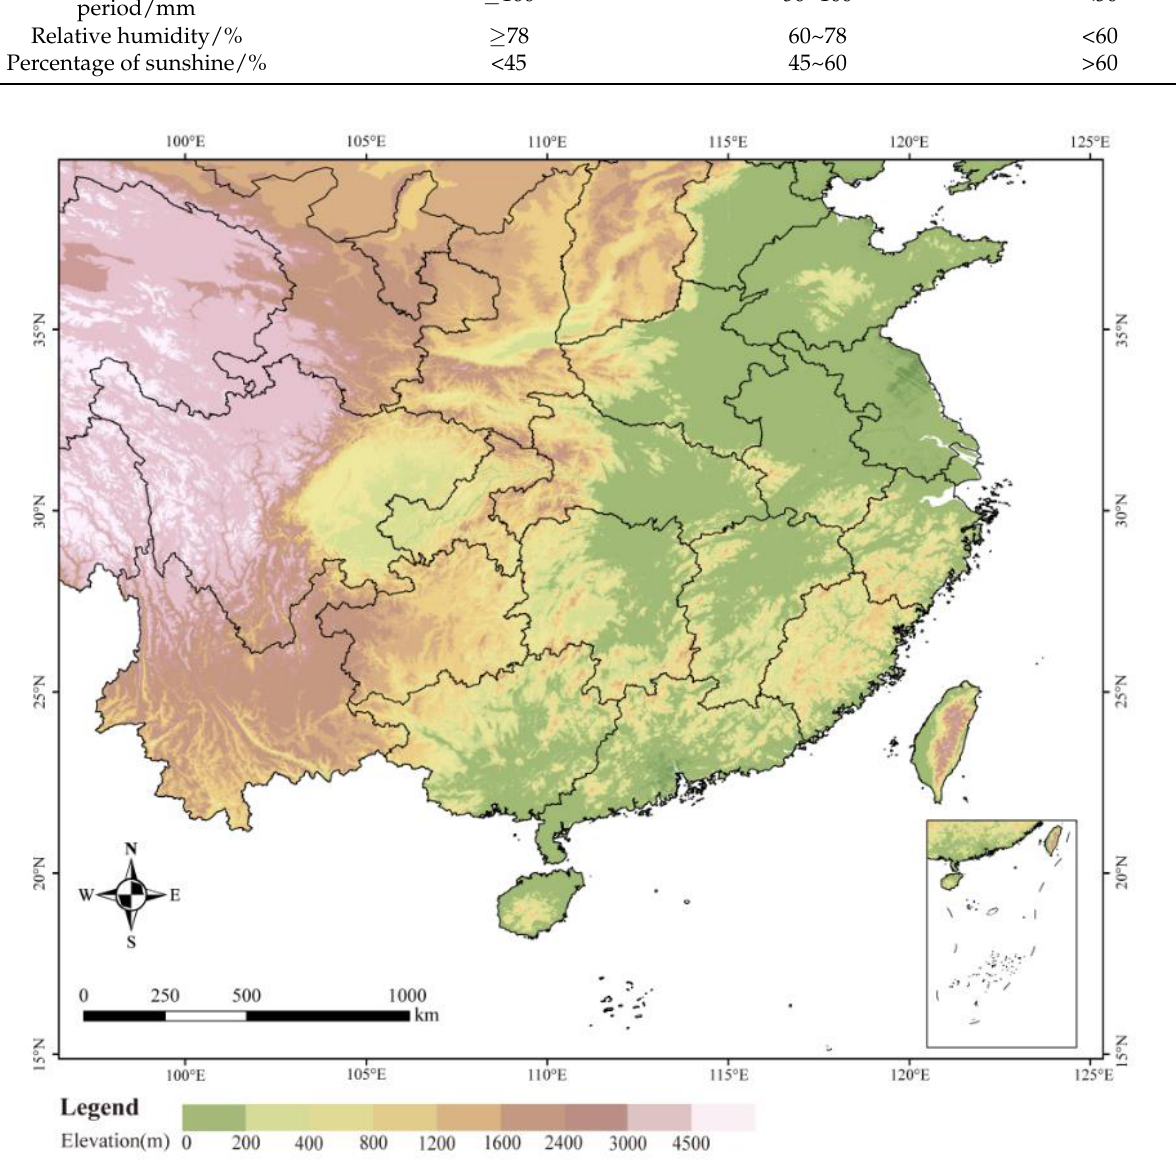
Figure A1. Topographic features of the study area.